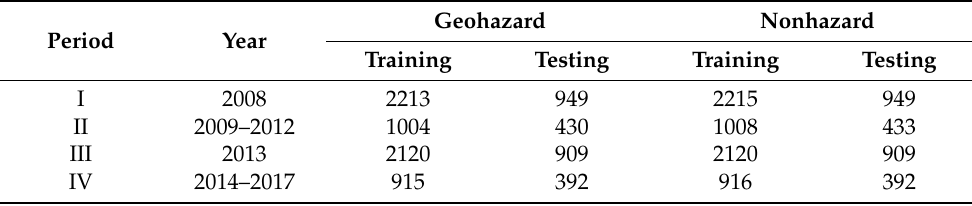
Table 1. Number of geohazard and nonhazard points in four periods. Geohazard Nonhazard Period Year Training Testing Training